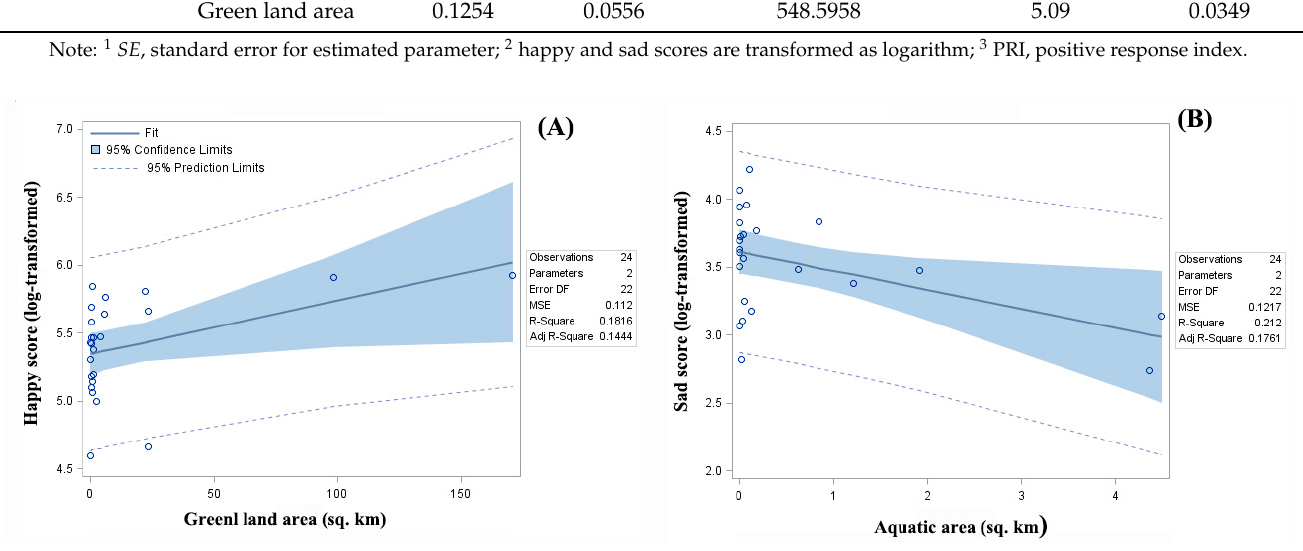
Figure 3. Curve fit of linear regression between green land area and logarithm-transformed happy scores ( A ) and between aquatic area and logarithm-transformed sad scores ( B ).